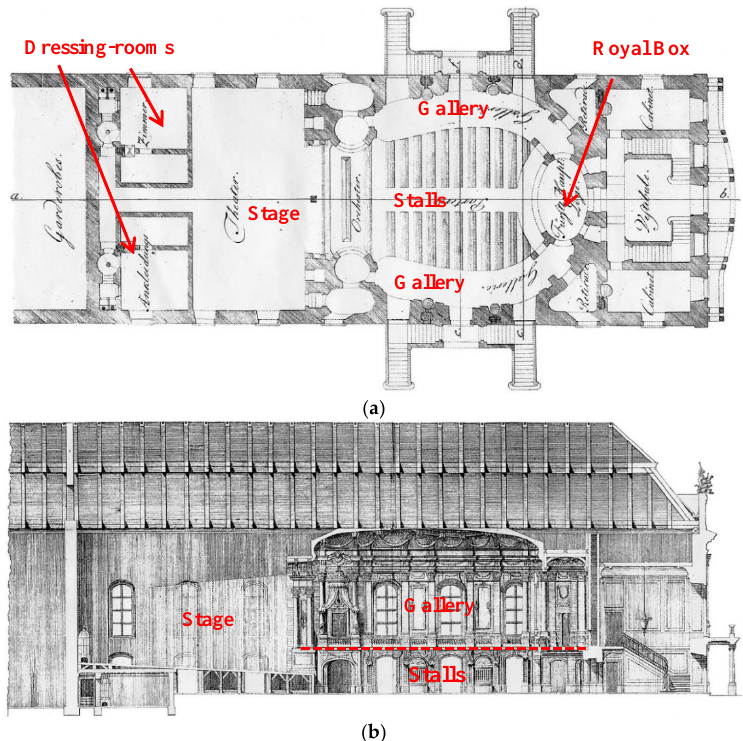
Figure 2. Drawings of Eszterháza Opera House in 1784: ( a ) plan of the theatre and ( b ) longitudinal section of the theatre – Modified [12].